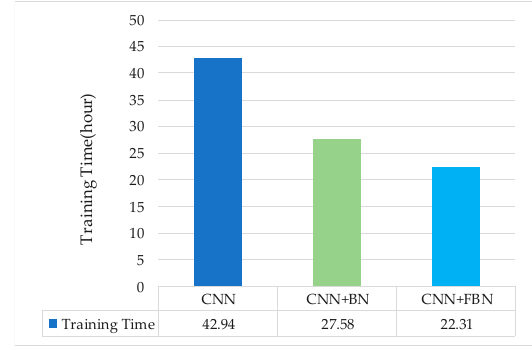
Figure 9. Comparison of network pre-training time for the three models.